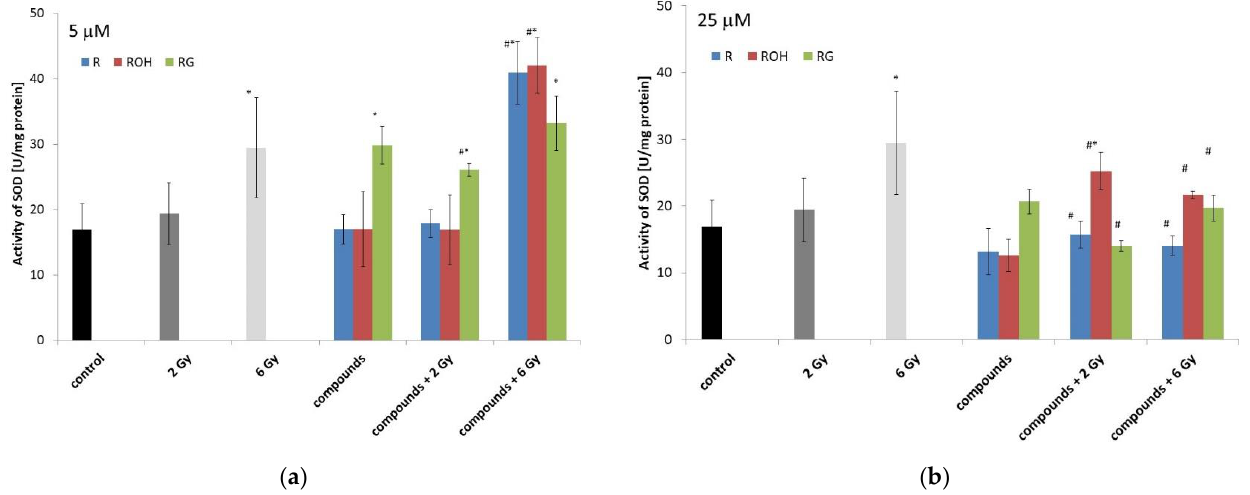
Figure 8. Effect of resveratrol (R), piceatannol (ROH), piceid (RG), ionising radiation, and their combinations on the superoxide dismutase (SOD) activity of MCF-7 cells. SOD activity was analysed after incubation of the cells for 48 h. Cells were treated with stilbene derivatives at concentrations of 5 µ M ( a ) and 25 µ M ( b ). All data are the average of three independent experiments, shown as the mean ± SD (two-way analysis of variance (ANOVA) followed by Tukey’s post hoc test, p < 0.05). The mean difference (*) was compared with the control and (#) with IR.